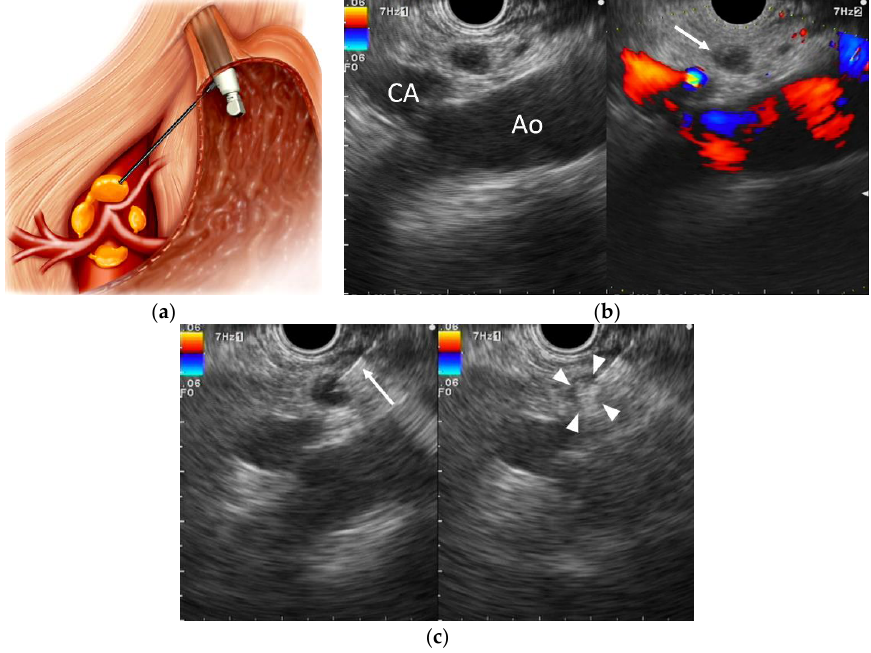
Figure 2. Endoscopic ultrasound-guided celiac ganglia neurolysis (EUS-CGN). ( a ) Schematic of EUS-CGN; ( b ) EUS image from the lesser curvature of the stomach showing the celiac ganglion located anterior to the aorta (arrow). Ao: aorta, CA: celiac artery. ( c ) EUS image of EUS-CGN before and after injection of a neurolytic agent. The ganglion has a hyperechoic appearance (arrowheads). Blue: vascular flow away from the transducer; Red: vascular flow towards the transducer.